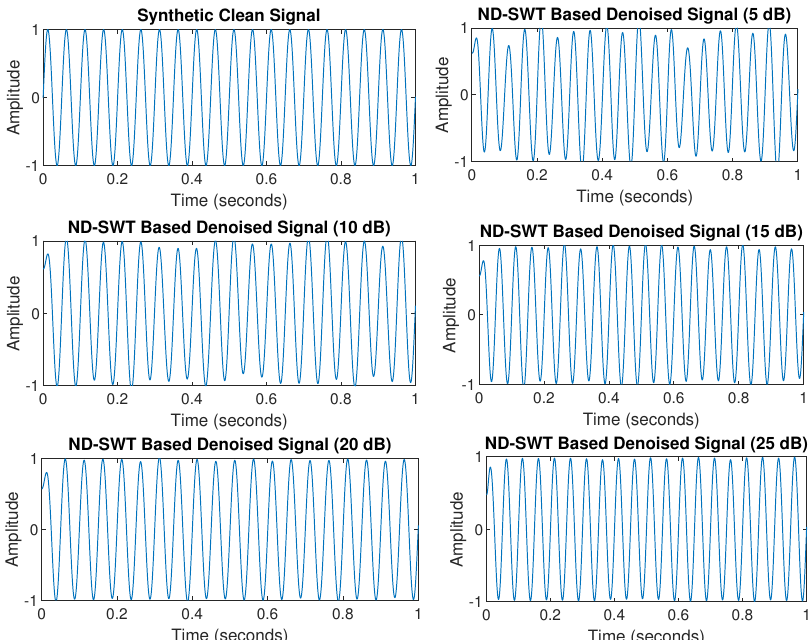
Figure 4. Synthetic clean signal and the ND-SWT-based denoised